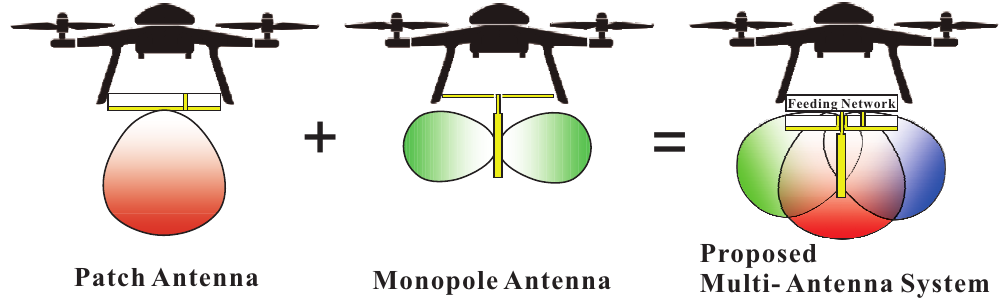
Figure 1. The conceptual diagram of the proposed antenna for UAV